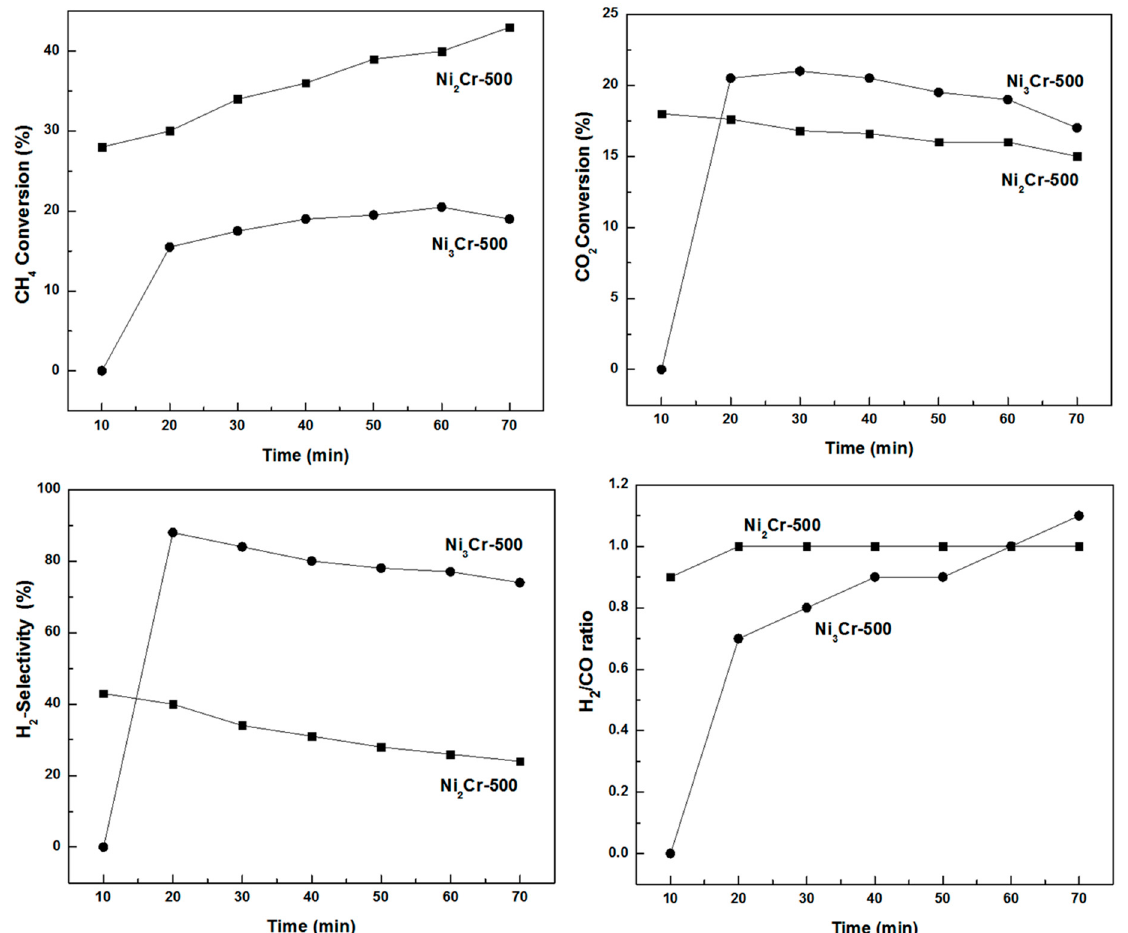
Figure 12. Isothermal test of catalytic performances in terms of conversions (CH 4 and CO 2 ), H 2 selectivity and H 2 /CO of fresh Ni 2 Cr-500 and Ni 3 Cr-500 catalyst at 500 °C. (CH 4 = 20%; CO 2 = 20%; 100 mg; F = 100 mL/min).